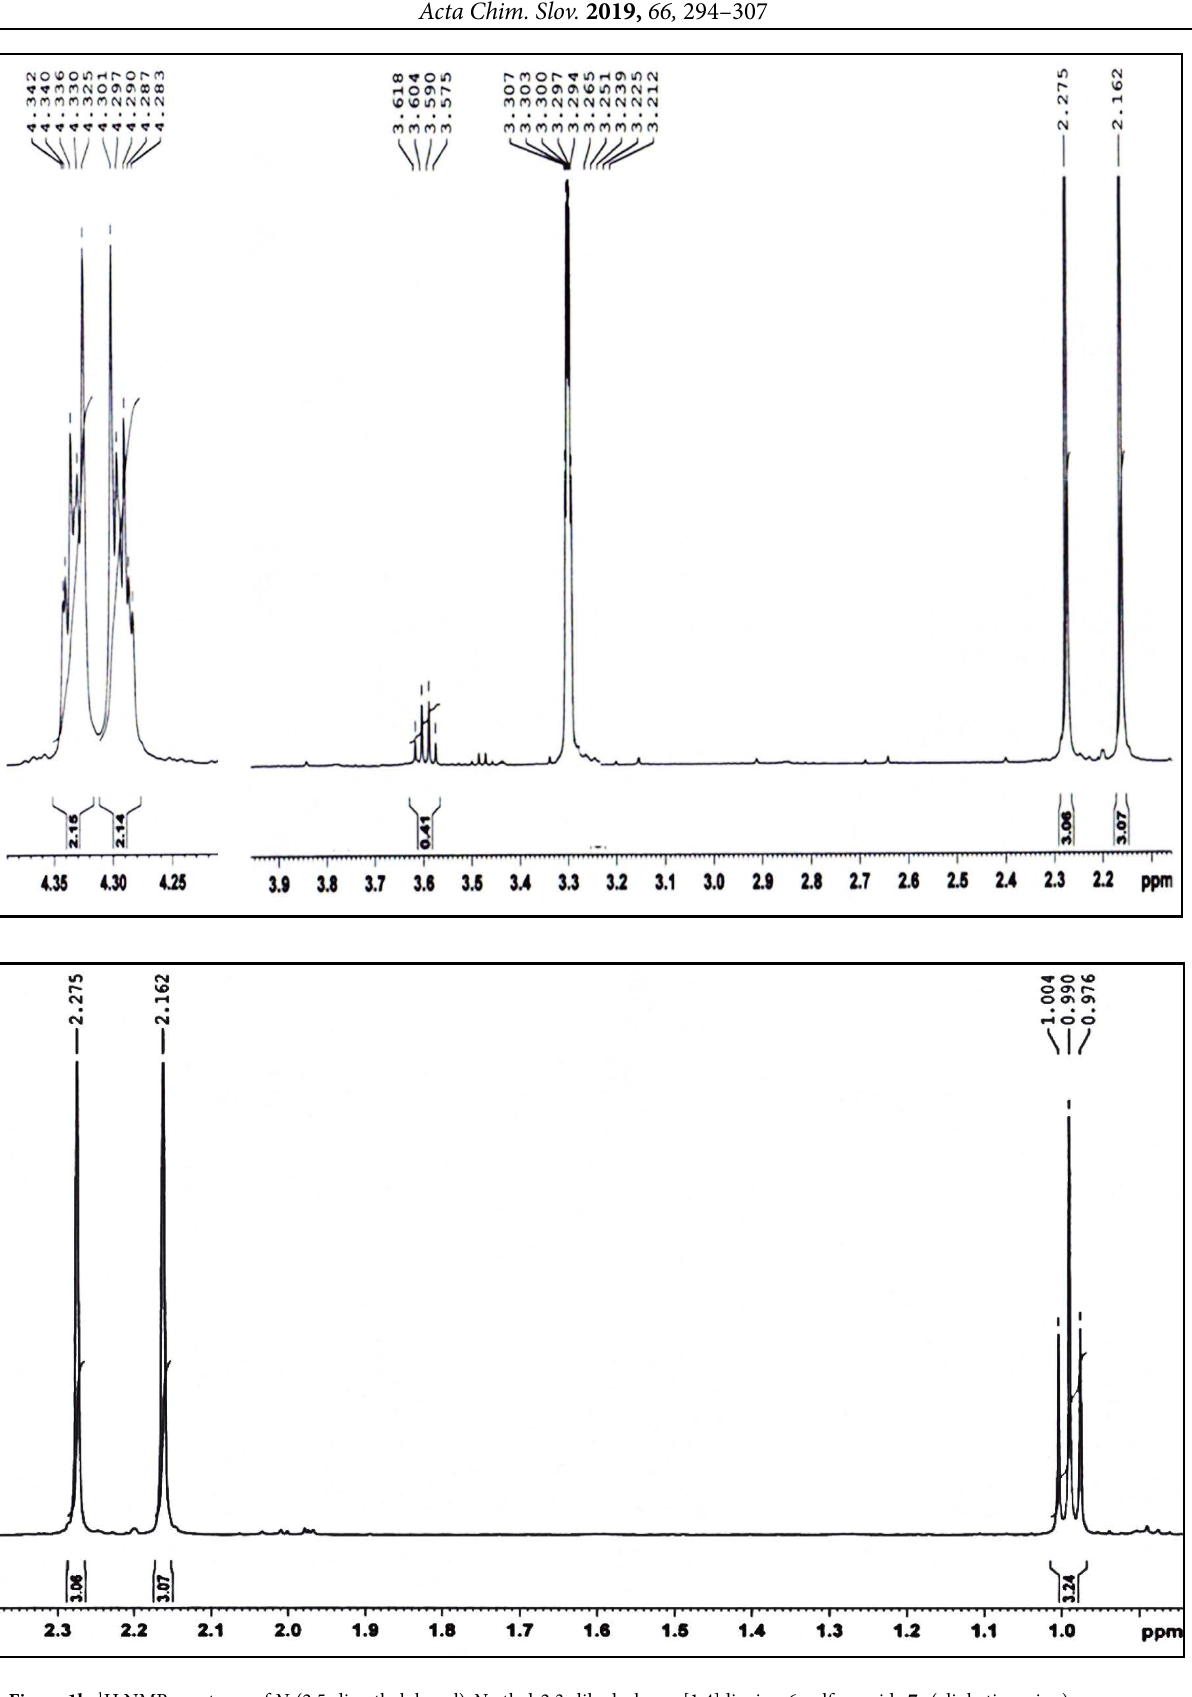
Figure 1b. 1 H NMR spectrum of N -(2,5-dimethylphenyl)- N -ethyl-2,3-dihydrobenzo[1,4]dioxine-6-sulfonamide 7c (aliphatic